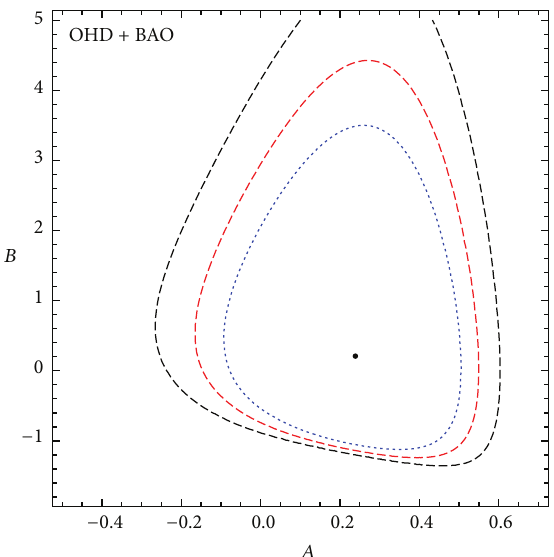
Figure 3: It shows the variations of 𝐴 with 𝐵 for 𝛼 = 0.1 for OHD + BAO + CMB and OHD + BAO + CMB + SNe analysis, respectively, for different confidence levels say 66% (solid, blue), 90% (dashed, red), and 99% (dashed, black)